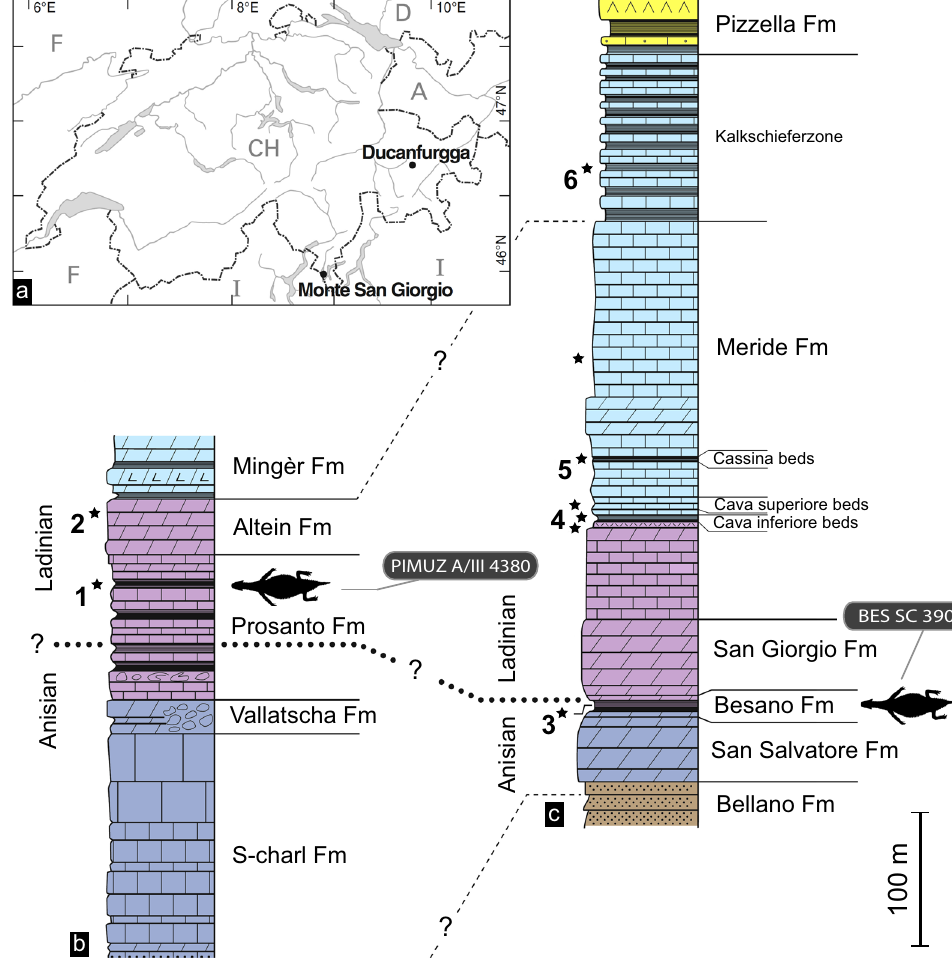
Figure 1. Locality and stratigraphic position of the alpine specimens of Eusaurosphargis dalsassoi (PIMUZ A/ III 4380 and holotype specimen BES SC 390). ( a ) Map showing the Ducanfurgga locality relative to the World Heritage vertebrate site of Monte San Giorgio. ( b ) Correlation of the Middle Triassic section at Ducanfurgga (Upper Austroalpine Silvretta Nappe, south-eastern Switzerland) with that of ( c ) Monte San Giorgio (southern Alps, southern Switzerland). Reproduced from Fig. 1 of Fraser and Furrer (2013) 3 , with permission of the Swiss Geological Society. Relevant ages according to U-Pb zircon dating of volcaniclastic layers are 240.91 ± 0.26 Ma 19 (1 * ), 239.89 ± 0.21 Ma 19 (2 * ), 242.1 ± 0.6 Ma 55 (3 * ), 241.07 ± 0.13 Ma 20 (4 * ), 240.63 ± 0.13 Ma 20 (5 * ), and 239.51 ± 0.15 Ma 20 (6 *